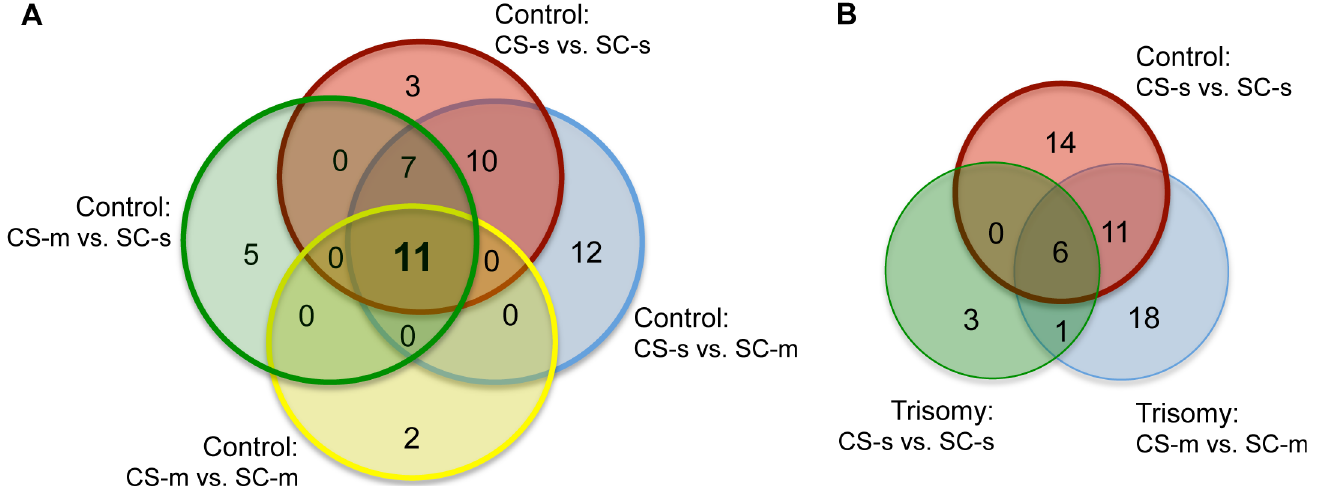
Fig 3. Venn diagrams of discriminating proteins. (A) Intersection of proteins discriminating learning in control mice. Colors indicate the proteins that respond in the four comparisons that reflect successful learning. (B) Intersection of proteins discriminating between normal, failed and rescued learning. Red circle: number of discriminant proteins between CS-s and SC-s in control (Normal learning; repeated from panel A). Blue circle: number of proteins that respond when learning is rescued in trisomic mice with memantine (CS-m vs. SC-m). Green circle: number of discriminant proteins in comparison CS-s vs. SC-s in trisomy (Failed